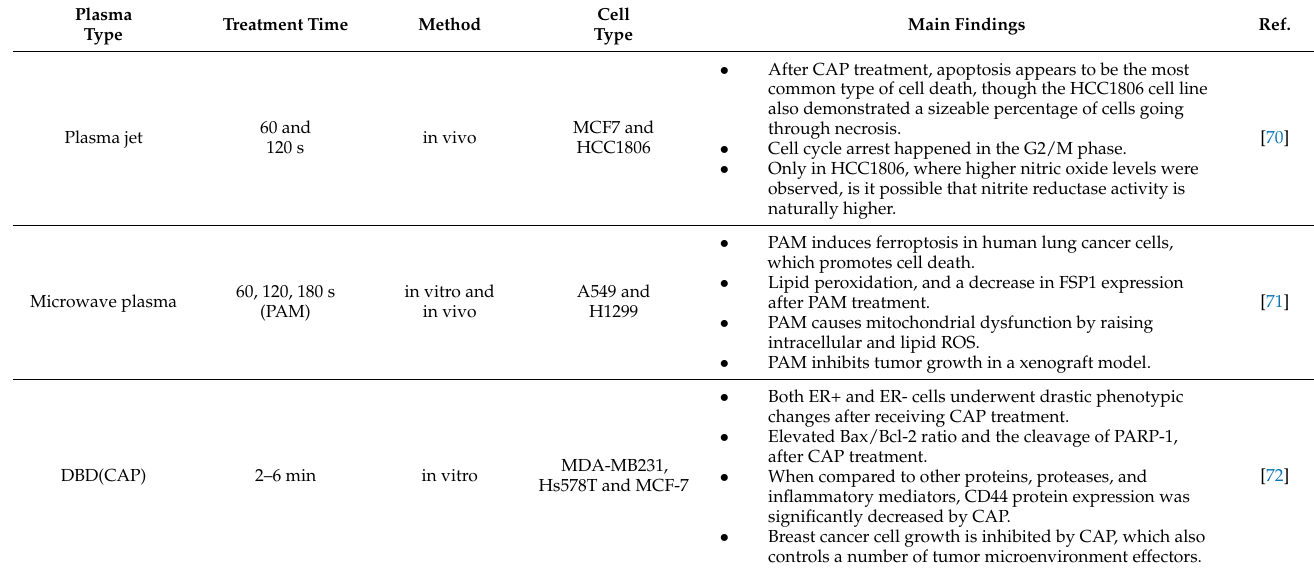
Table 1. An overview of recent NTP developments for anti-cancer